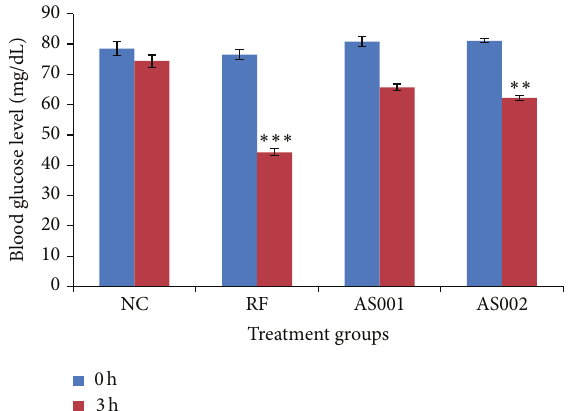
Figure 3: Effect of Pupalia lappacea extract on 18h fasted rats. Values are expressed as mean ± SEM (number of animals, 𝑛 = 6 ); NC = normoglycemic control, RF = reference group (glibenclamide, 5.0 mg/kg), significantly different at ∗∗ 𝑝 < 0.05 , ∗∗∗ 𝑝 < 0.001 when compared with diabetic control